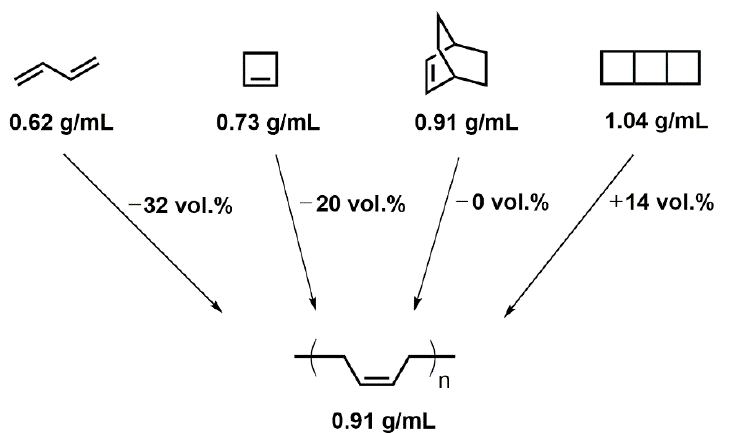
Figure 2. Molecular structure and density of 1,3-butadiene, cyclobutene, bicyclo[2.2.2]oct-2-ene, tricyclo[4.2.0.0 2,5 ]octane, and poly(butadiene). The density of 1,3-butadiene (0.62 g·mol − 1 ; no ring present) [8], cyclobutene (0.73 g·mol − 1 ; 1 ring present) [9], bicyclo[2.2.2]oct-2-ene (0.91 g·mol − 1 ; 2 rings present) [10], and tricyclo[4.2.0.0 2,5 ]octane (1.04 g·mol − 1 ; 3 rings present) [11] increases alongside with the num-